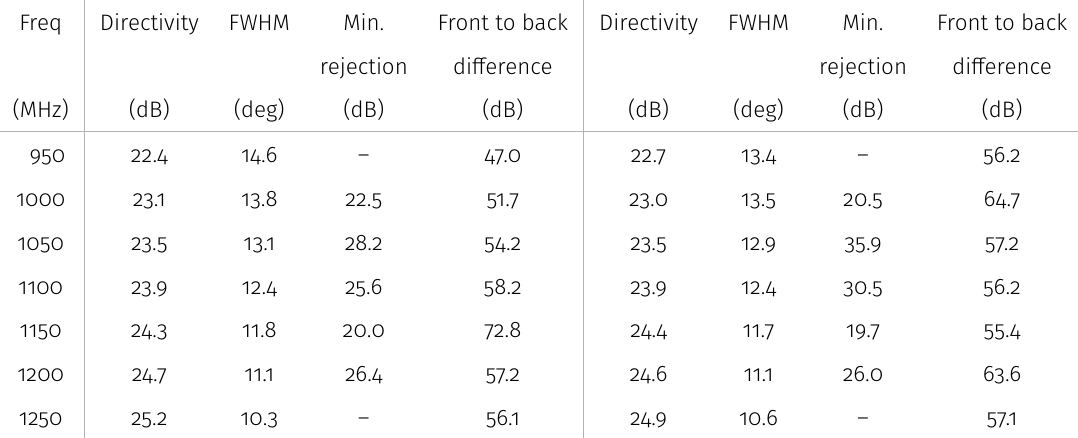
Table III. Feedhorn beam measurements. Left: horizontal polarisation. Right: vertical polarisation. Minimum rejection was not measured at all